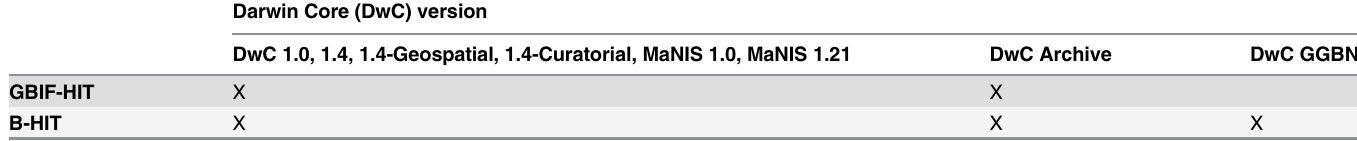
Table 2. Darwin Core versions supported by the GBIF-HIT and B-HIT. Darwin Core (DwC)